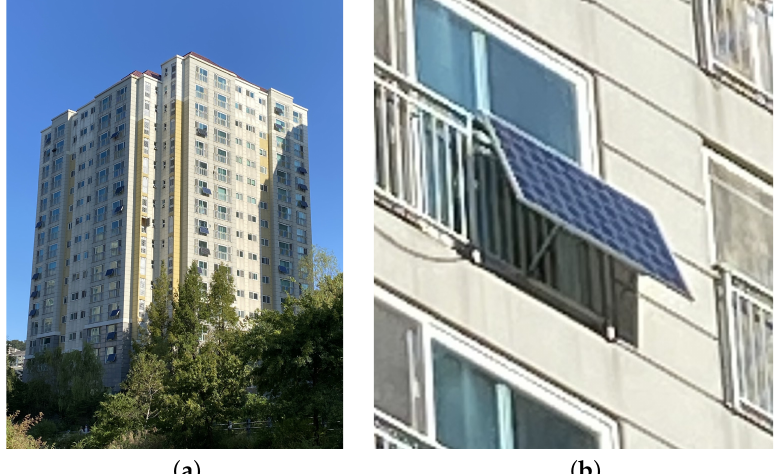
Figure 1. ( a ) The actual solar panel installed in the apartment. ( b ) An enlarged